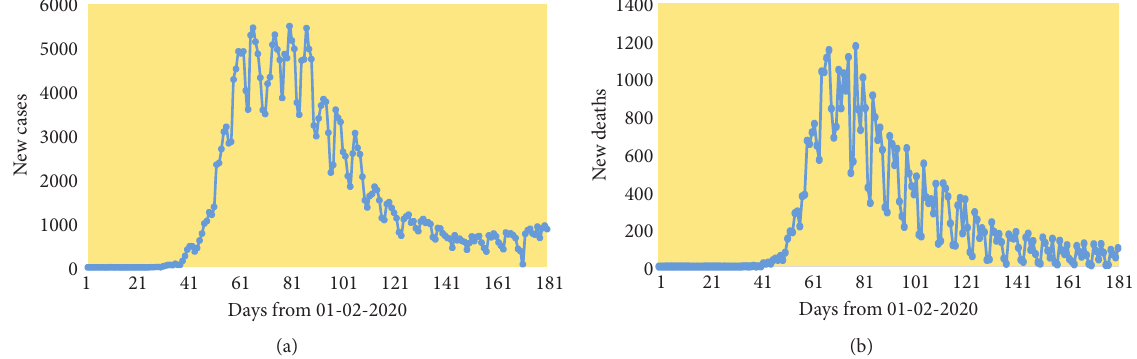
Figure 1: (a) Trends in daily new cases, UK; (b) trends in daily new deaths,